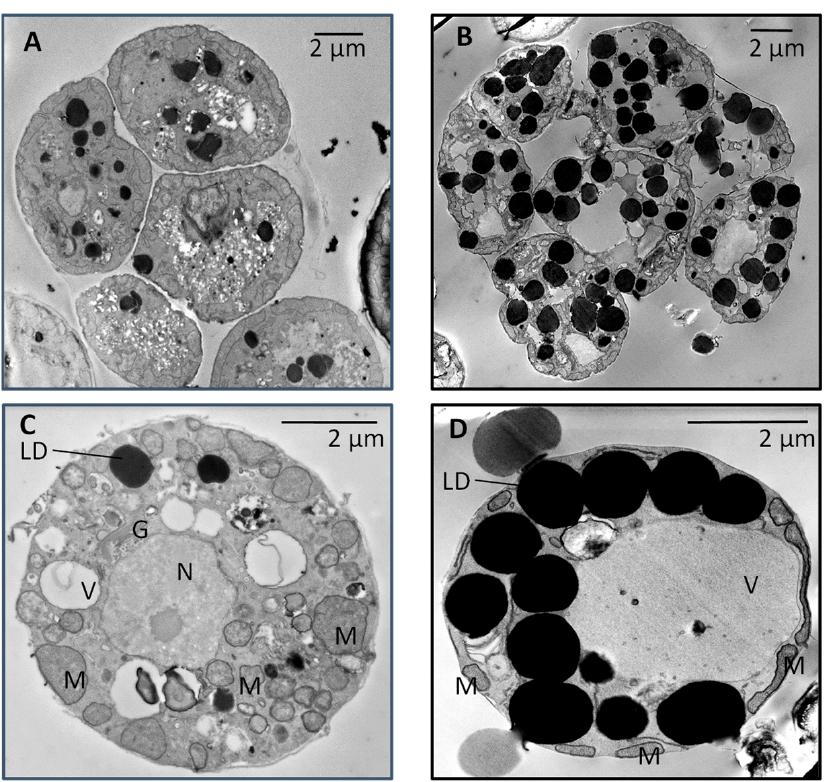
Figure 1. Scanning transmission electron microscopy (SEM) pictures of Arantiochytrium limacinum ( A , C ) 2-day-old culture of the WT; ( B , D ) 2-day-old culture of the LAS mutant. ( A , B ) show a group of cells, and ( C , D ) show the detailed structures of a single cell. The oil bodies appear as black spots. LD, lipid droplets; V, vacuole; M, mitochondria; N, nucleus; G, Golgi